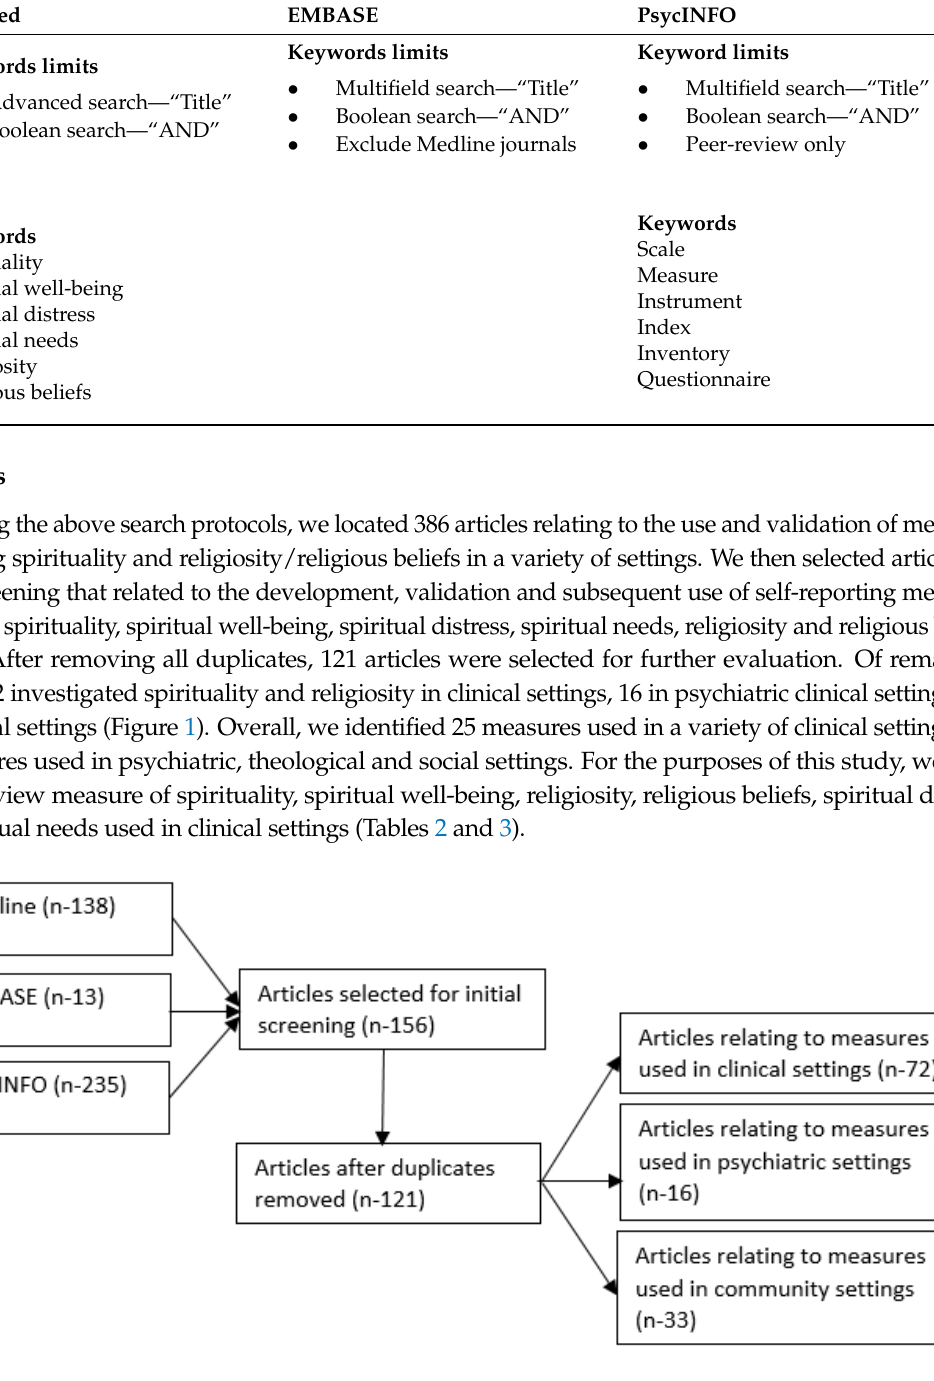
Figure 1. Search flow chart showing total numbers of articles located and screen for Figure 1 . Search flow chart showing total numbers of articles located and screen for review.